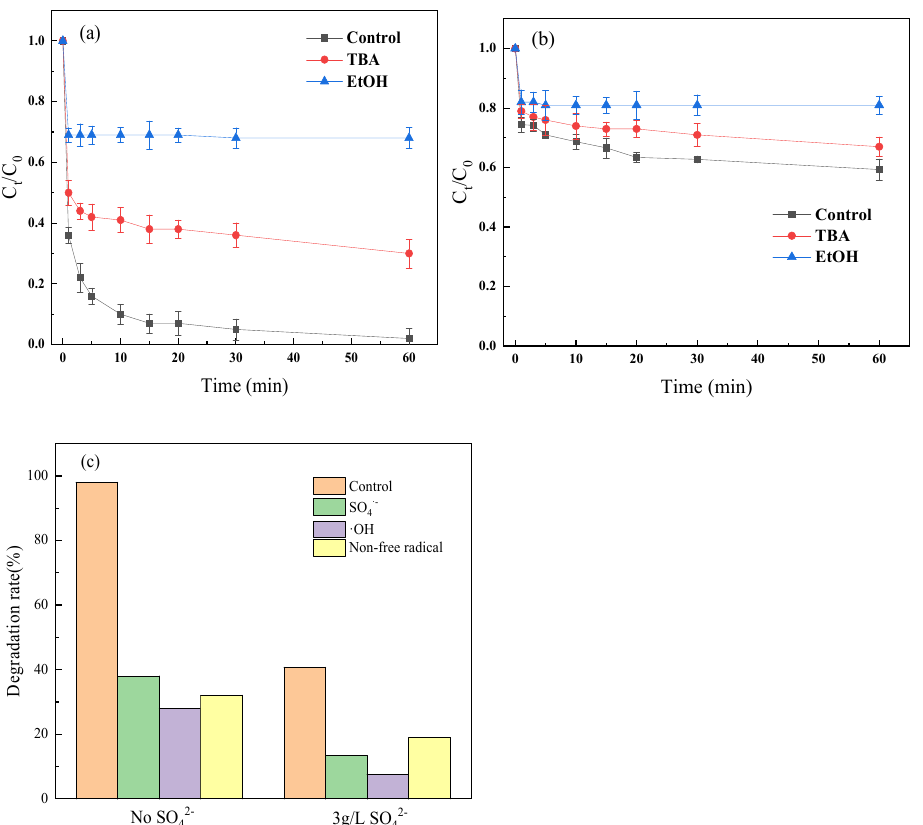
Figure 3. Free radical quenching experiment: ( a ) Na 2 SO 4 free; ( b ) [Na 2 SO 4 ] = 3 g/L; ( c ) contribution of reactive substances to the overall degradation efficiency. Reaction conditions: [PS] = 40 mg/L, Fe 2+ /PS = 0.3, pH = 7, [TBA] 0 = 0.5 mM, and [EtOH] 0 = 0.5 mM.